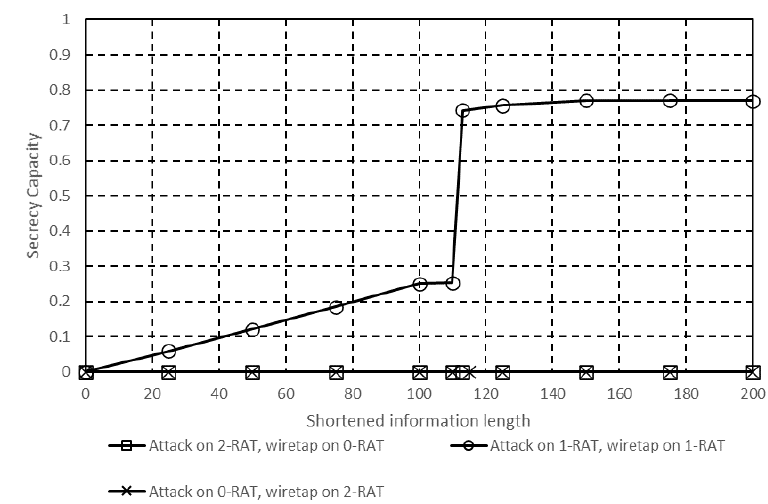
Figure 11. Characteristics of the secrecy capacity versus the shortened information length when the sender and the receiver communicate using two RATs. The square marks, the circle marks and the cross marks indicate the secrecy capacity of the cyberterrorist attacking on two RATs, attacking on one RAT and wiretapping on one RAT, and wiretapping on two RATs, respectively.